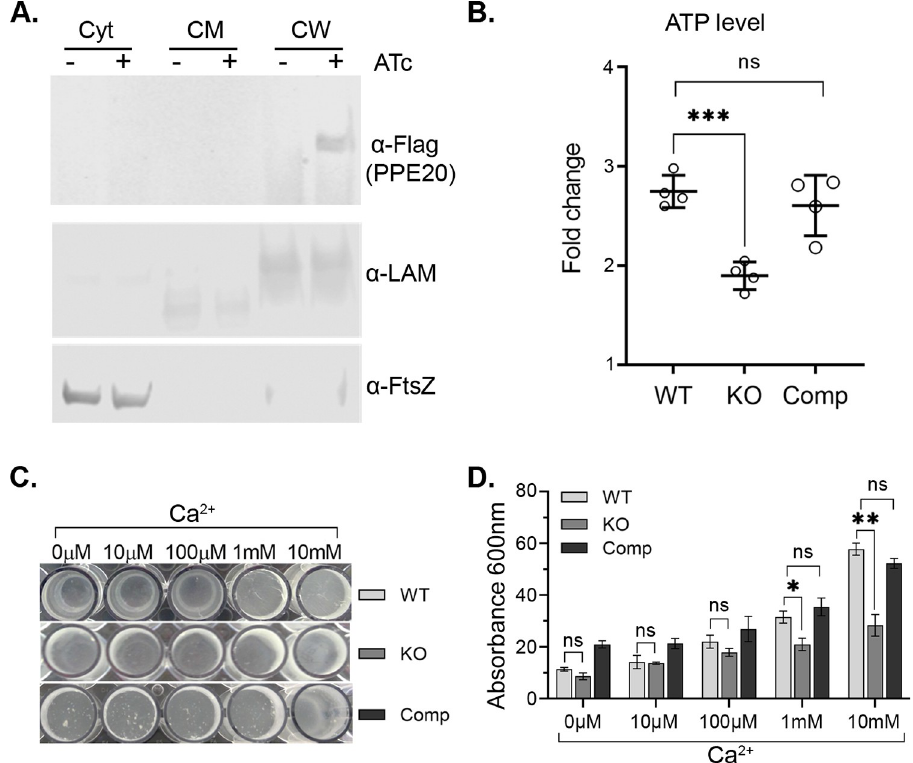
Fig 3. pe15/ppe20 affects Ca 2+ associated processes and facilitates Ca 2+ uptake. (A) Western blot showing localization of PPE20 to the cell wall. Subcellular fractions from the complemented pe15 / ppe20 KO strain expressing PPE20-FLAG were probed with α -FLAG antibody. Cyt: cytosolic fraction, CM: cell membrane fraction, CW: cell wall fraction. LAM is a cell envelope marker and FtsZ is a cytosolic marker. (B) PE15/PPE20 affect cellular ATP levels. Mtb was treated with 1 mM Ca 2+ at 37˚C and ATP quantified using BacTiter-Glo reagent. Fold change was calculated by comparing to the Ca 2+ -free condition. Data shown are from 4 experiments, error bars show standard deviation ( ns p > 0.05, ��� p < 0.001). (C) PE15/PPE20 affect biofilm formation. Cultures were grown with increasing concentrations of Ca 2+ and biofilm was quantified by crystal violet (D). The experiment was repeated 3 times, error bars show standard error ( ns p > 0.05, � p < 0.05, �� p < 0.01). The data underlying all the plots and uncropped images in this figure are included in S1 Data and S1 Raw images. Ca 2+ , calcium ion; Comp, complement; KO, knockout; WT, wild